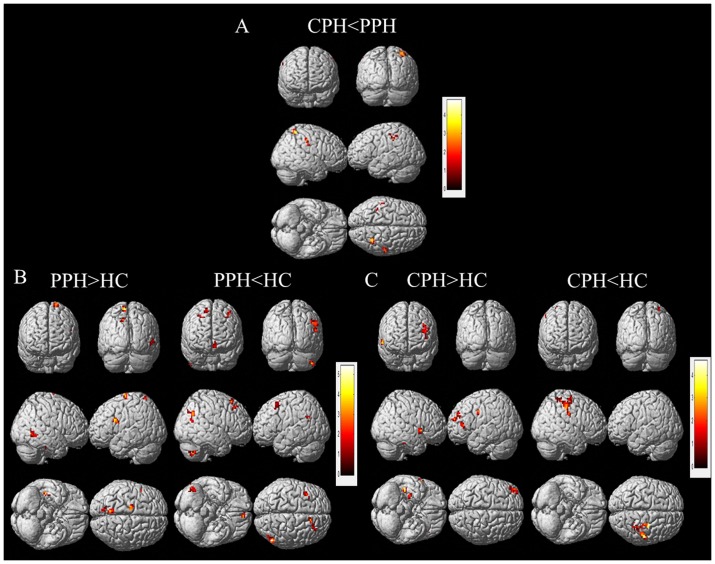
Significant differences in the functional connectivity of ipsilesional M1 between each pair of the three diagnostic groups.A: CPH versus PPH; B: PPH versus HC; C: CPH versus HC. The threshold was set at a combined cutoff value of p<0.01 and a minimum cluster size of 486 mm3 (18 voxels) to yield a corrected threshold of p<0.05 (AlphaSim corrected). Clusters with significant differences were overlapped on render views (posterior-anterior (row 1), right-left (row 2), inferior-superior (row 3)). Color scale = t values.